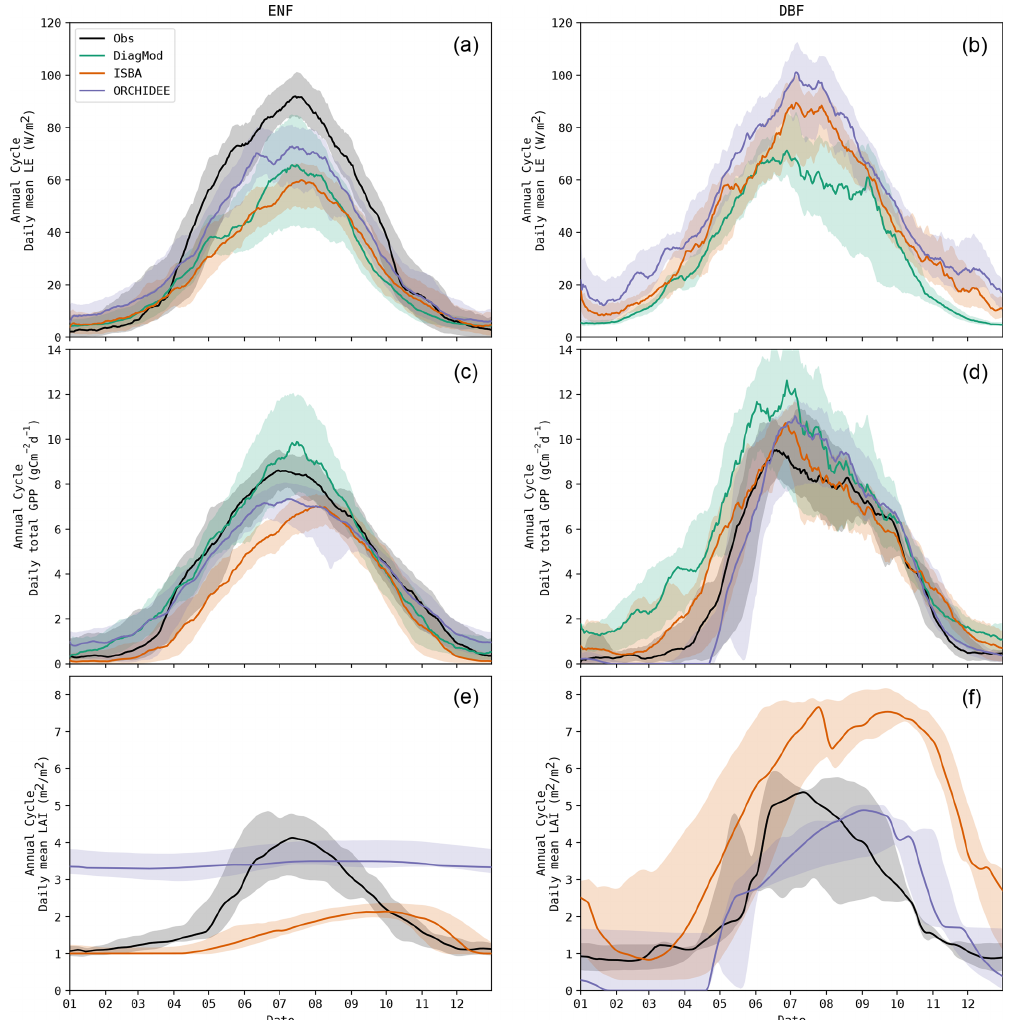
Figure 6. Mean annual cycle for LE , GPP and LAI in all evergreen needleleaf forest (a, c, e) and deciduous broadleaf forest (b, d, f) sites, observed and simulated. Note: corrected LE observations were missing at all DBF